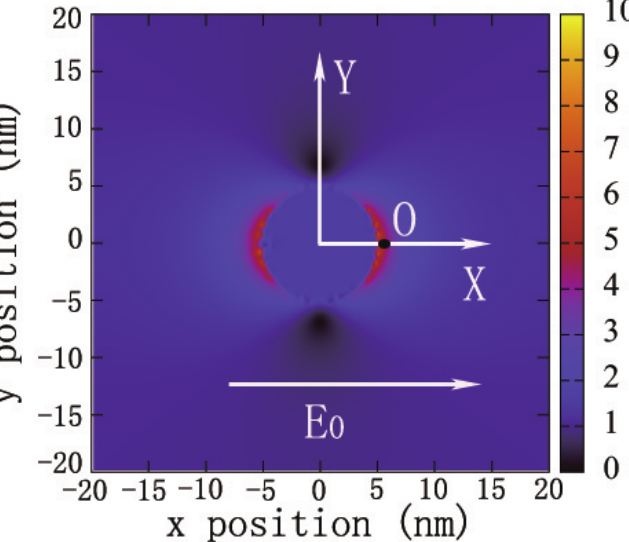
Figure 3. The contour of a surface localized field generated by an Ag NP sphere with R = 5 nm. The arrow denotes the field polarization direction. The magnitude of the field intensity E is indicated by the color scale. The observation point ‘O’ is away from the NP surface, at a distance of L. The electric field is normalized to the incident